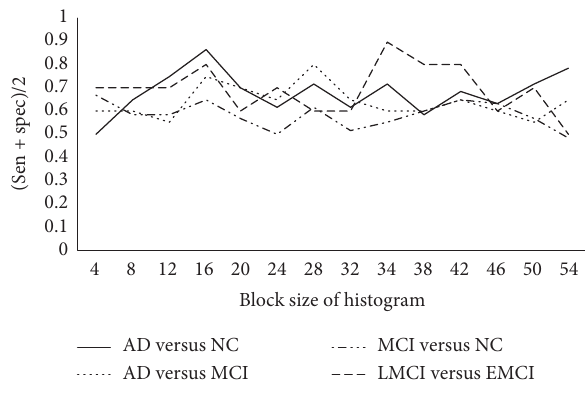
Figure 5: Accuracy of different block size.